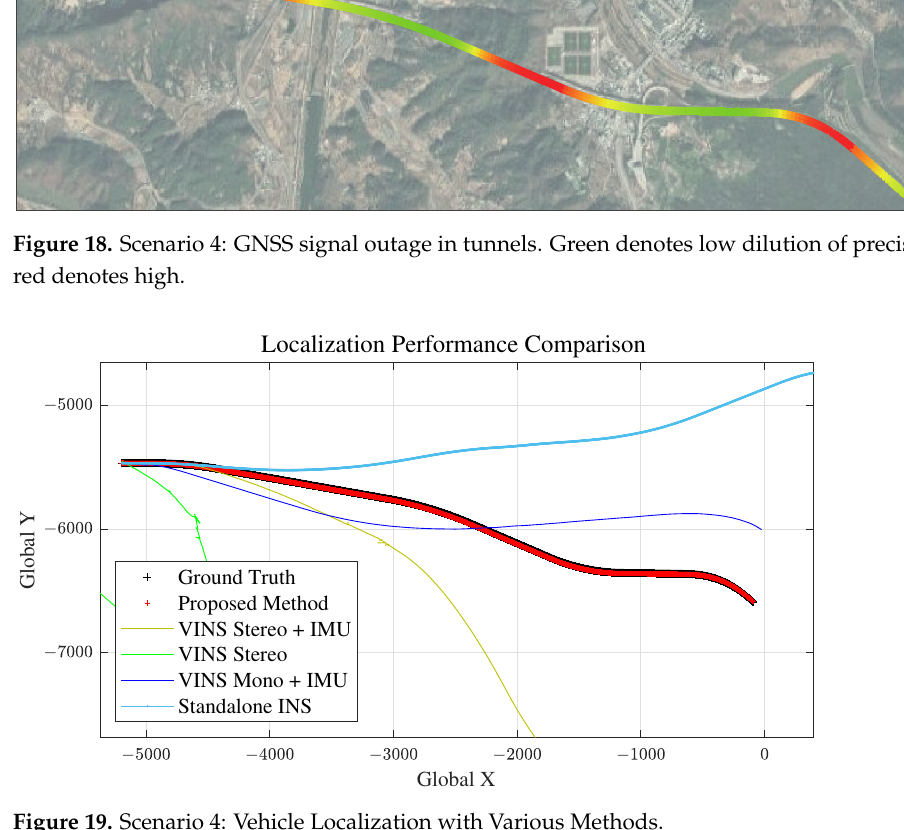
Figure 19. Scenario 4: Vehicle Localization with Various Methods.